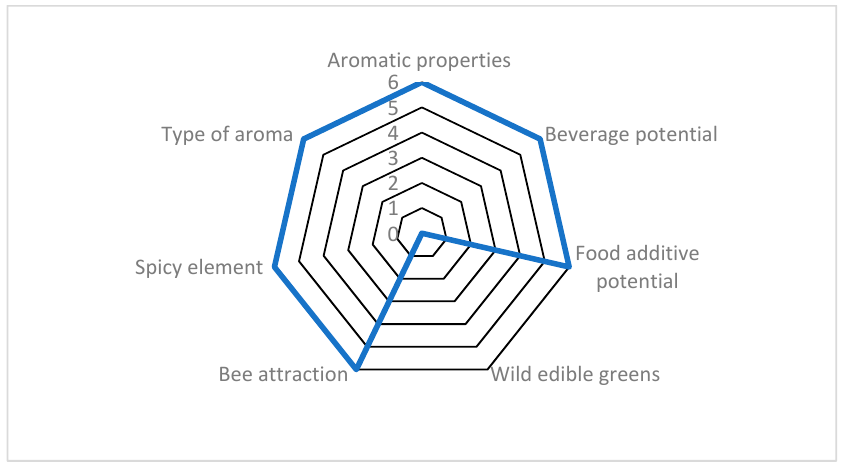
Figure 3. Evaluation example of Origanum dictamnus (Cretan endemic) scored for seven agro-alimentary attributes, reaching 85.7% of the optimum possible score. This example is hierarchically ranked in the highest (>70%) class. For attributes and scoring, see Section 4.